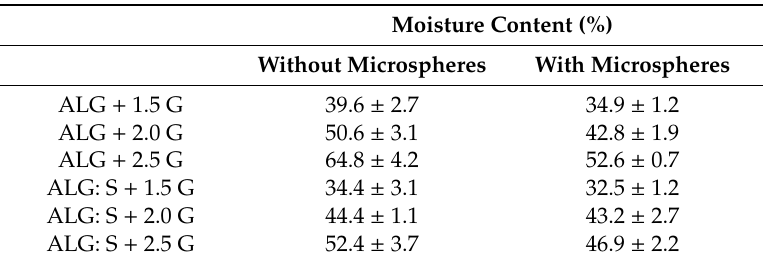
Table 3. The moisture content results of the prepared films based on sodium alginate, starch and glycerol: ALG + 1.5 G, ALG + 2.0 G, ALG + 2.5 G—samples based on sodium alginate containing 1.5%, 2%, and 2.5% of glycerin, respectively. ALG: S + 1.5 G, ALG: S + 2.0 G, ALG: S + 2.5 G samples based on sodium alginate and starch containing 1.5%, 2%, and 2.5% of glycerin, respectively.